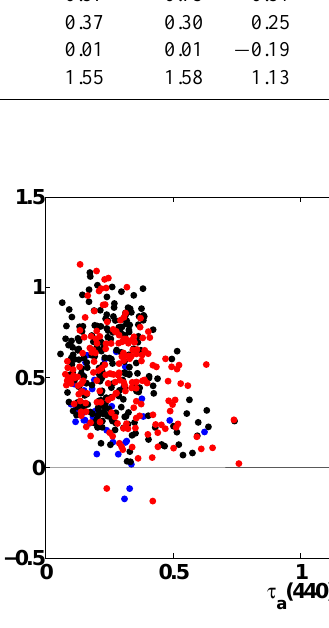
Fig. 5. Correlation between the coefficient α 2 computed in the spec- tral interval 440–870nm and AOD (440nm), the IASBS site, Octo- ber 2006 to September